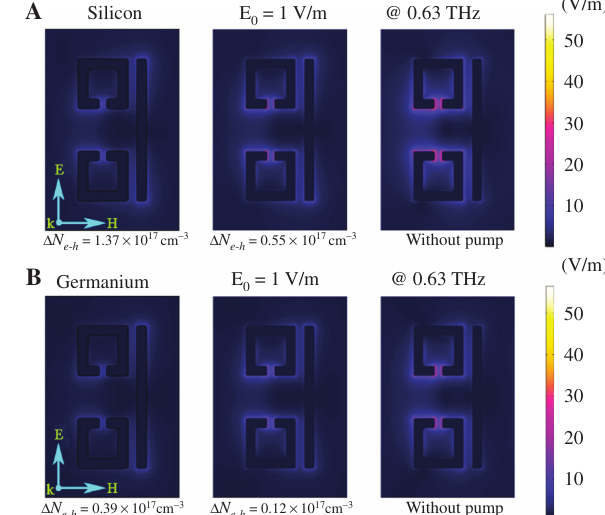
Figure 4: Calculated electric field distributions in the transverse plane of the EIT Au metasurface at 0.63 THz. (A) Simulated evolution of electric field distributions vs. the charge (B) The evolution of electric field distributions vs. the carrier density ∆ N from 0 to 0.12 and 0.39 × 10 17 cm −3 of the Ge film. Incident e-h = 1 V/m. Polarization directions of fields are normalized as E 0 electric field of incident fields are marked by the white